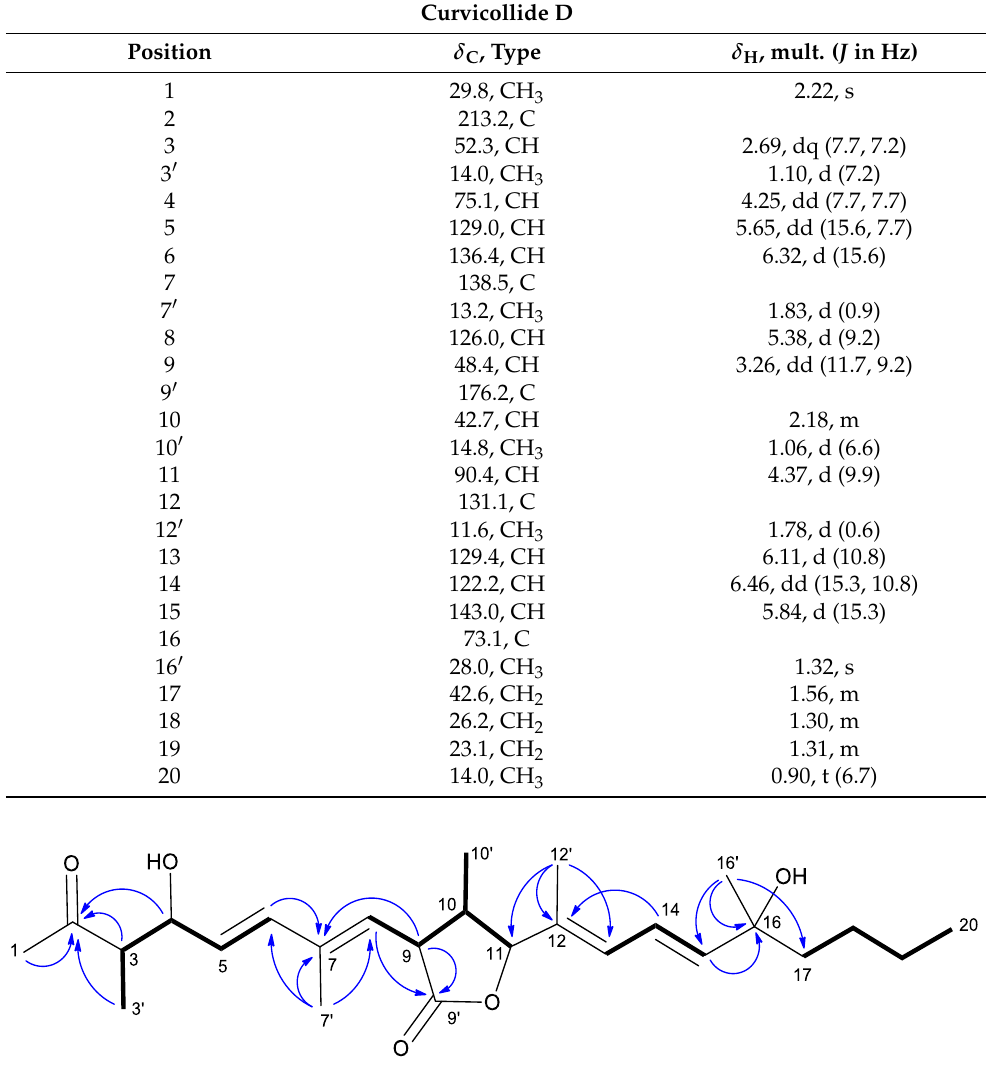
Table 1. NMR data for curvicollide D in (500 MHz, CDCl 3 , 24 ◦ C).